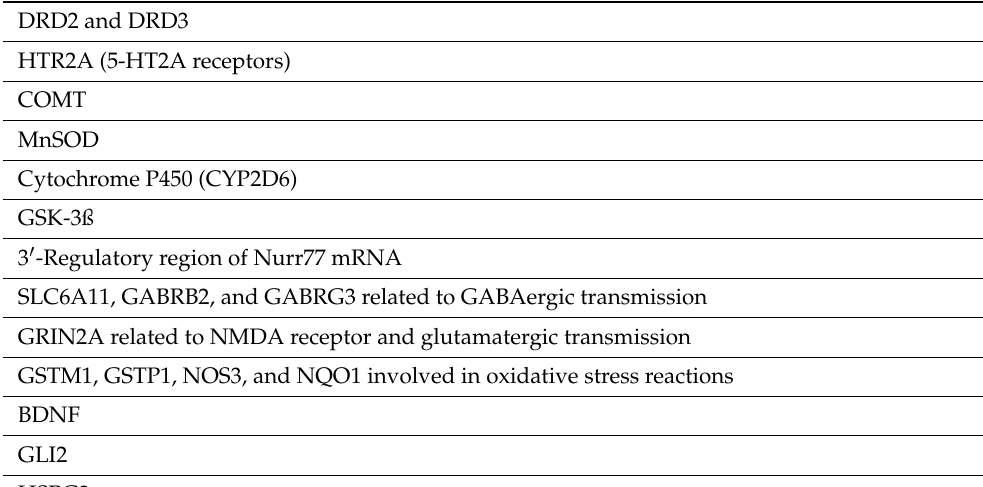
Table 2. Genes whose polymorphisms increase the risk of